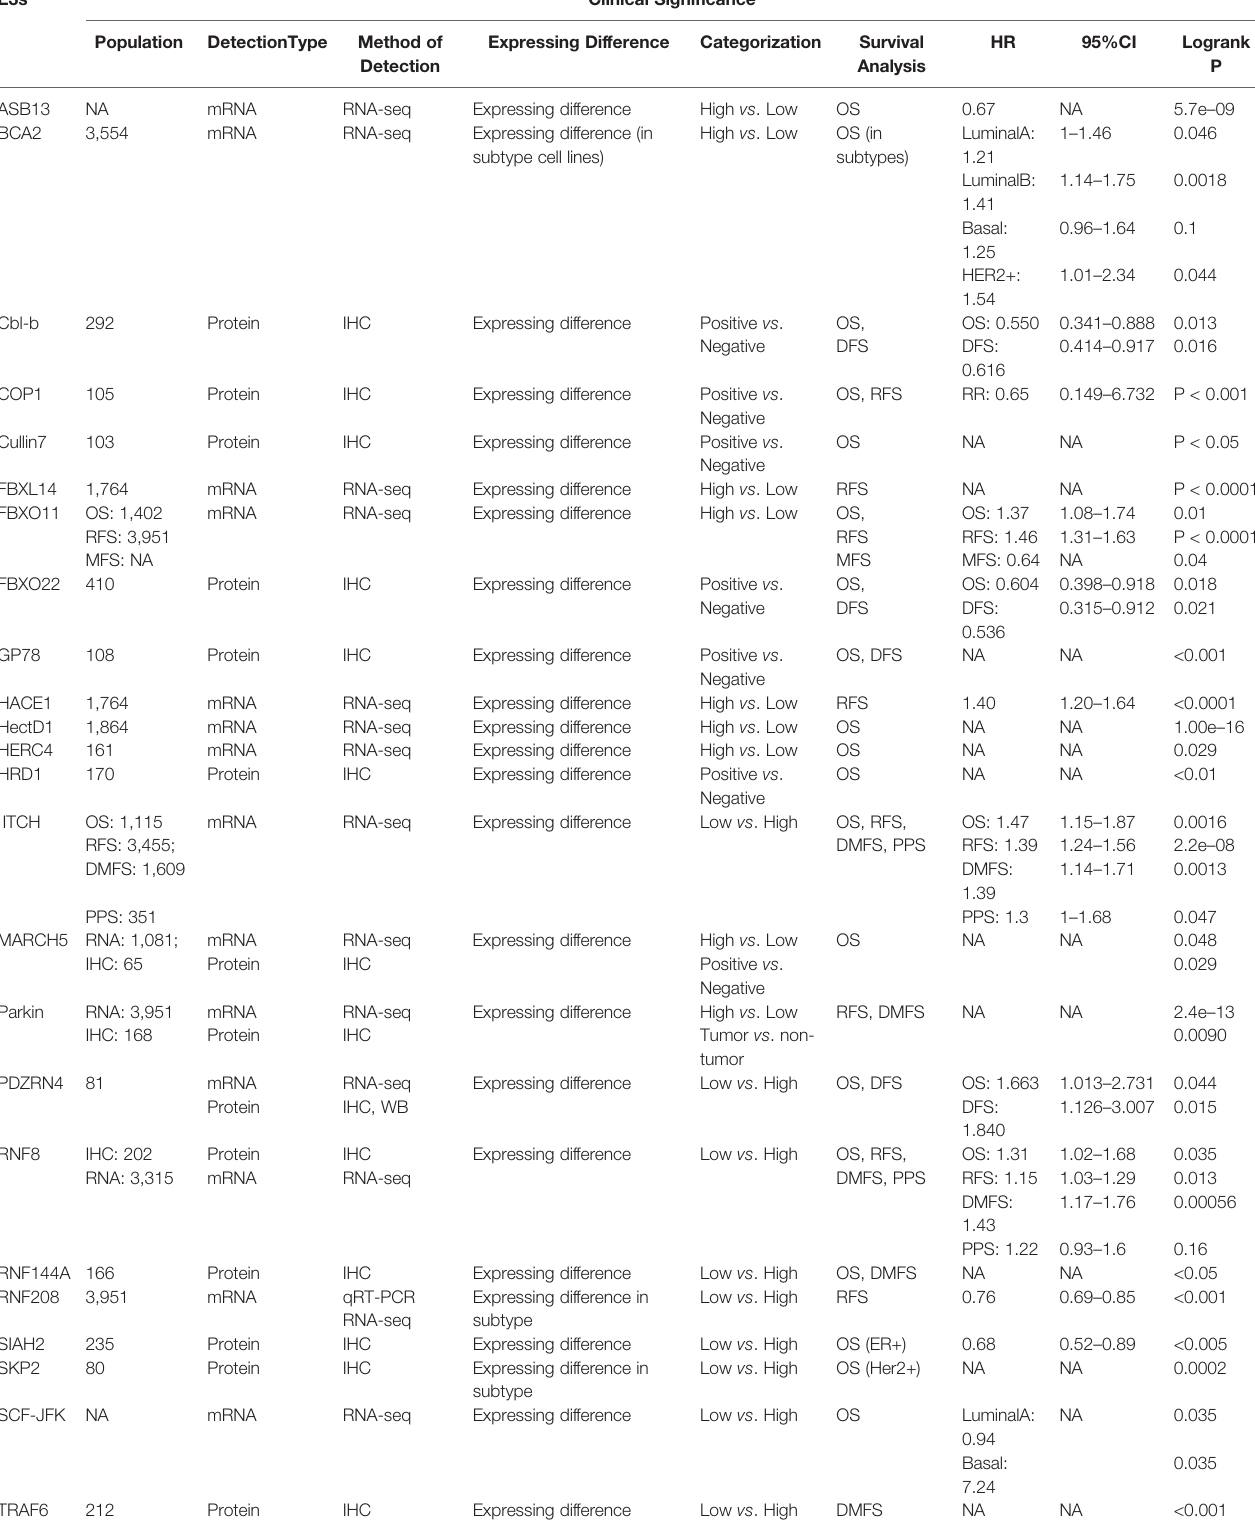
TABLE 2 | E3s are signi fi cantly correlated with patients ’ survival.